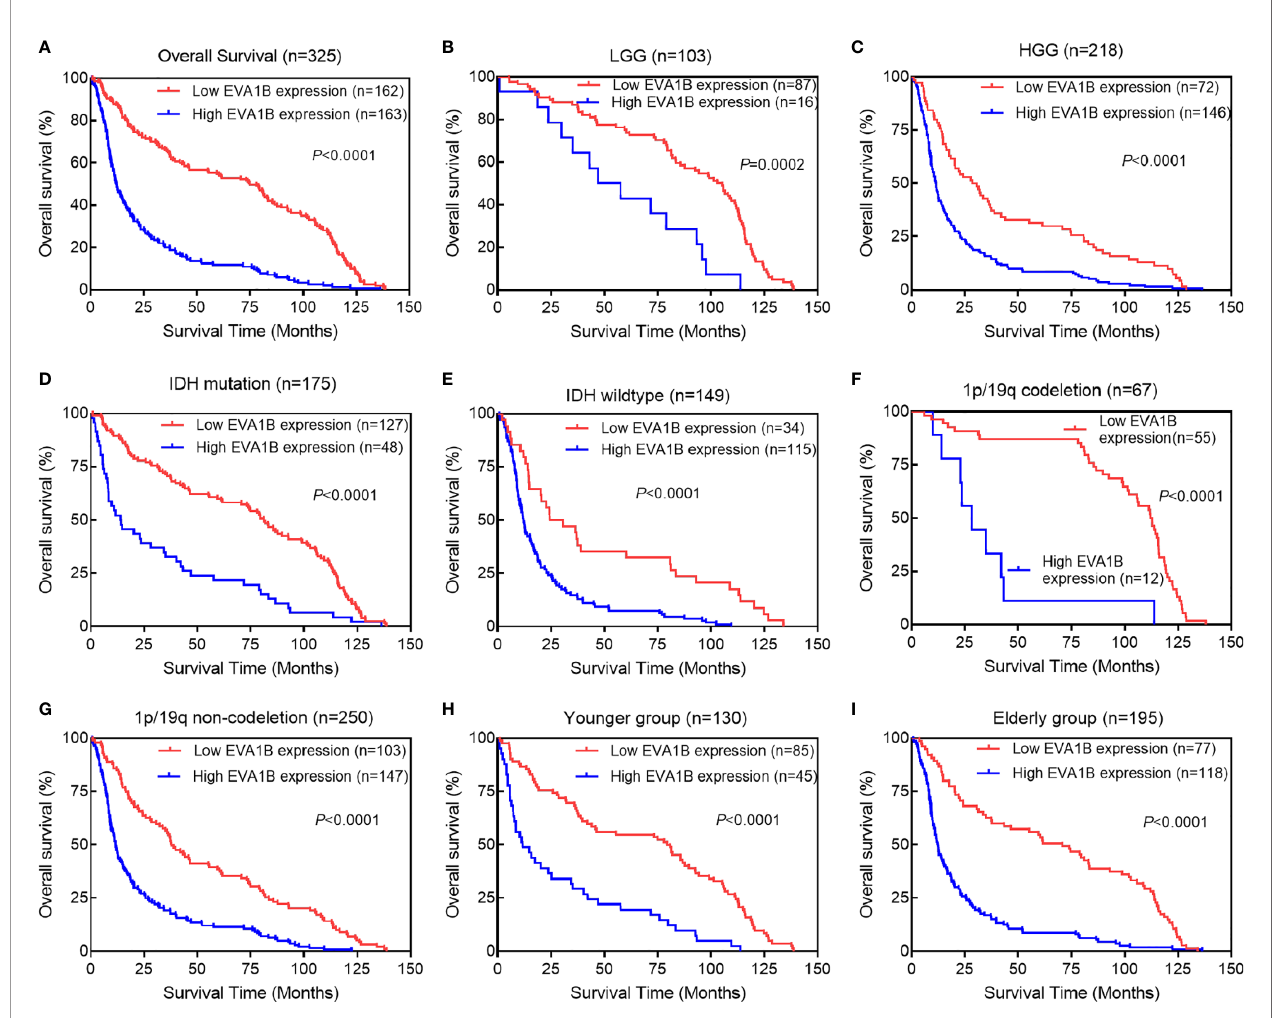
FIGURE 3 | The association between EVA1B expression and prognosis of glioma patients. (A) Overall, Kaplan-Meier curves showed that patients with EVA1B overexpression have a poorer prognosis than those with low expression. (B – I) In the subgroup analysis, patients with EVA1B overexpression showed signi fi cantly poorer prognosis than those with low expression in the LGG subgroup, HGG subgroup, IDH mutation subgroup, IDH wildtype subgroup, 1p/19q codeletion subgroup, 1p/19q non-codeletion subgroup, younger subgroup, and elderly